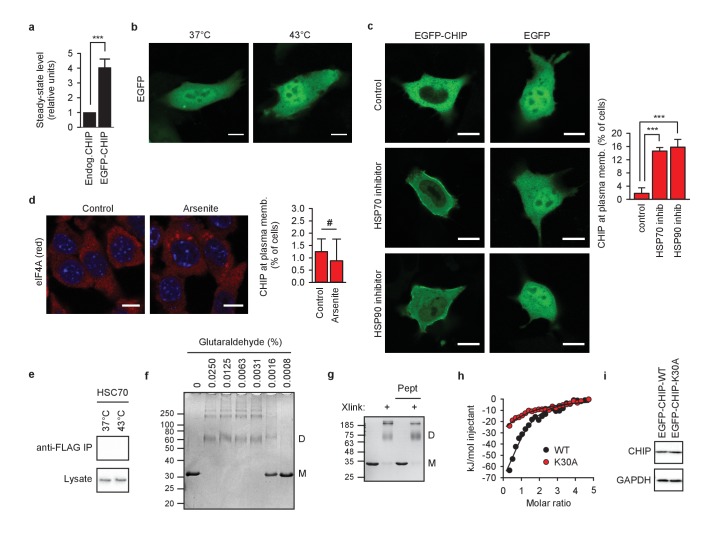
Chaperone-free CHIP association with cellular membranes.(a) Comparison of steady-state levels of endogenous CHIP and EGFP-CHIP 24 hr after transfection by means of western blotting with anti-CHIP antibody (mean ± SD). ***p<0.001, t-test analysis, N = 3 independent experiments. (b) Heat shock at 43°C does not cause EGFP association with membranes. One representative out of three independent experiments is shown. Scale bar 10 μm. (c) Inhibitors of HSP70 (20 μM VER-155008 for 4 hr) and HSP90 (20 μM 17-AAG for 4 hr) mimic the heat shock effect in regard to CHIP relocalization to membranes in murine fibroblasts (mean ± SD). EGFP-transfected cells were used as control. One representative experiment out of three is shown. Scale bar 10 μm. ***p<0.001, chi-square analysis; N = 3 independent experiments. (d) 0.5 mM arsenite treatment for 30 min does not induce CHIP relocalization to membranes in murine fibroblasts (mean ± SD). #, no statistically significant difference according to chi-square analysis; N = 3 independent experiments. Immunofluorescent staining of eIF4A (red) was used to confirm stress granule formation. DAPI staining in blue. (e) HSC70 does not bind to anti-FLAG matrix in empty vector-transfected cell lysates. One representative experiment out of four is shown. (f) Chemical crosslinking captures CHIP dimers and oligomers in vitro as determined by Coomassie Blue-stained reducing SDS-PAGE gel. M, monomers; D, dimers. One representative out of three experiments is shown. (g) CHIP oligomers cannot be fully disassembled by excess of C-terminal octapeptide from HSP70 (Pept) in vitro as determined by Coomassie Blue-stained reducing SDS-PAGE gel. Xlink, crosslinked samples; M, monomers; D, dimers. One representative out of three experiments is shown. (h) K30A mutation affects CHIP binding to HSP70 as measured by isothermal titration calorimetry using C-terminal octapeptide of HSP70 at 37°C. WT, K30A, wild-type CHIP and K30A mutant, respectively. (i) WT and K30A mutant CHIP have similar steady-state levels upon transient transfection as determined by western blotting. GAPDH was used as loading control. One representative out of three independent experiments is shown.